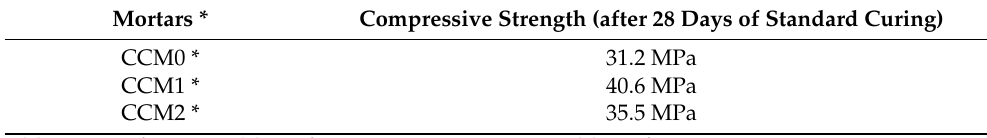
Table 8. Compressive strength of